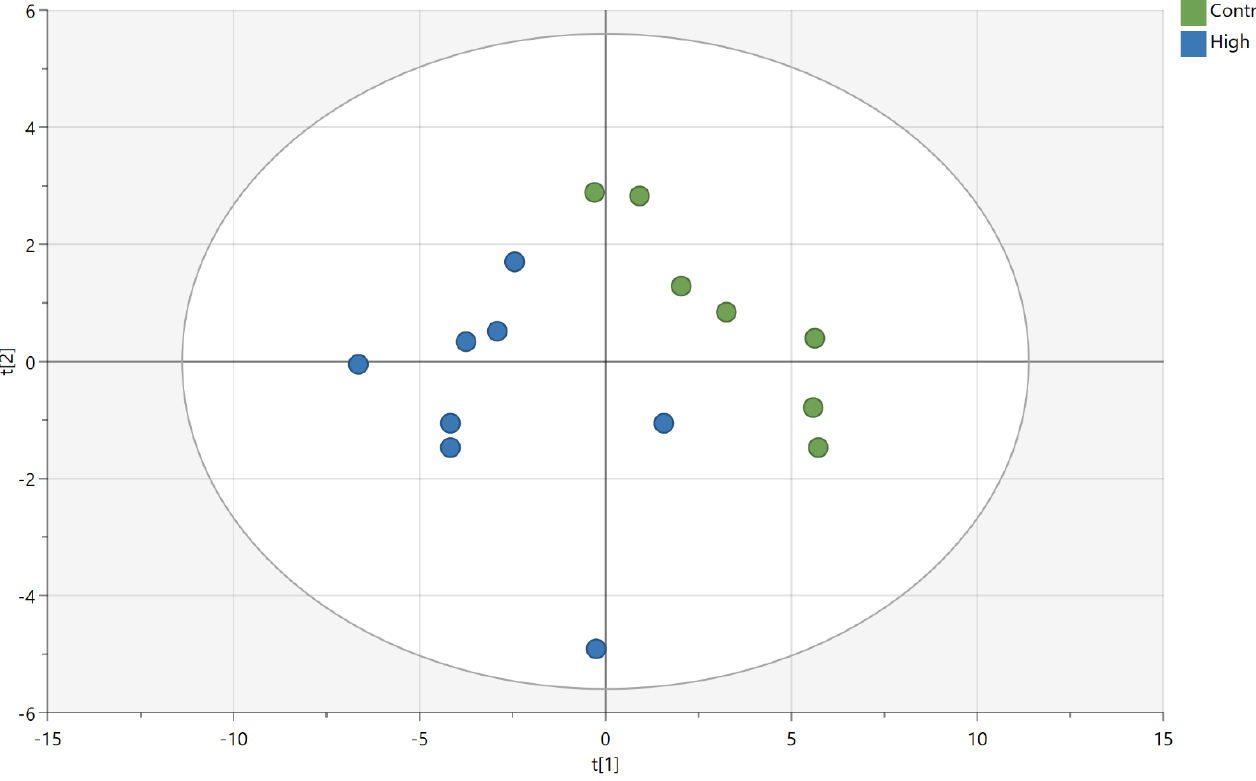
Figure 5. PLS-DA plot of lipids measured in the hippocampus of pigs fed the high-MFGM supplemented infant formula or control formula in positive ionization mode, (n = 15 animals) Q2(cum) = 0.78. Control is the unsupplemented (control) infant formula; High is the highest level of the MFGM supplemented in infant formula.